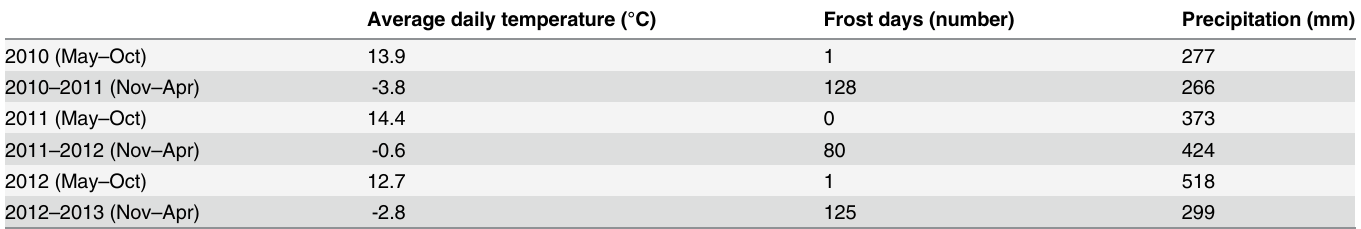
Table 6. Average daily temperature (°C), number of frost days, and cumulative precipitation as rainfall (mm) during and between the growing